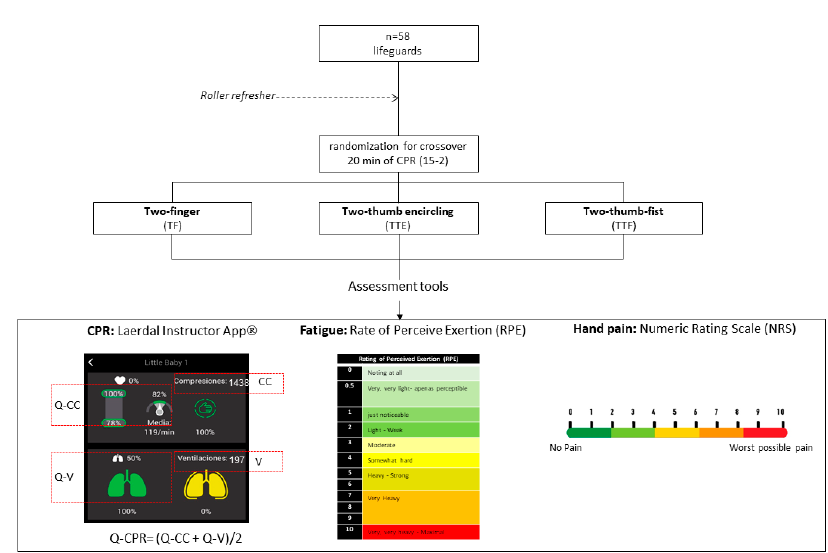
Figure 2. Flow chart design and assessment tools.